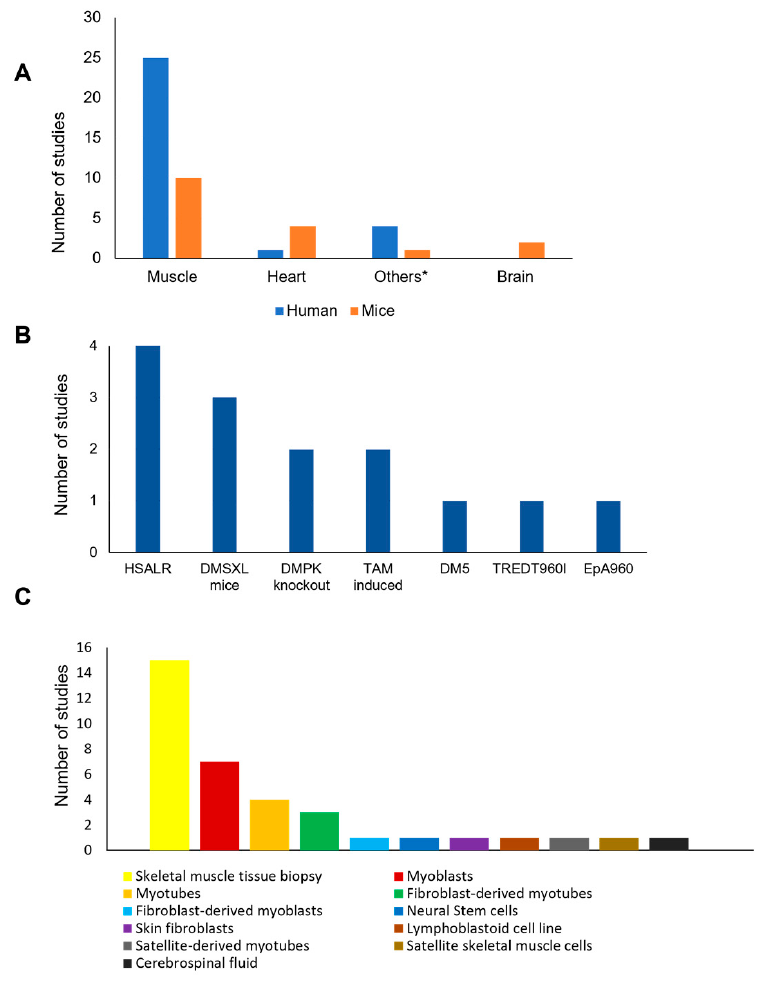
Figure 2. Type of biological sample used and diversity of mice models, human cell types, and body fluids used in the selected studies. ( A ) Type of organs and tissues used across the studies; ( B ) DM1 mice models used in the selected studies; ( C ) Type of human samples used across the studies. DM5—RNA toxicity model; DMPK knockout—Mice models without the dystrophia myotonica protein kinase gene; DMSXL—Transgenic mice carrying >1000 CTG repeats; HSALR—Transgenic mice expressing the human skeletal actin gene with long CUG repeat length; TAM induced—Tamoxifen-inducible and heart-specific EpA960(R) RNA expression model; TREDT960I—Tetracycline-inducible transgene model; EpA960—interrupted 960-CTG expansion model. * Other organ and tissue derived